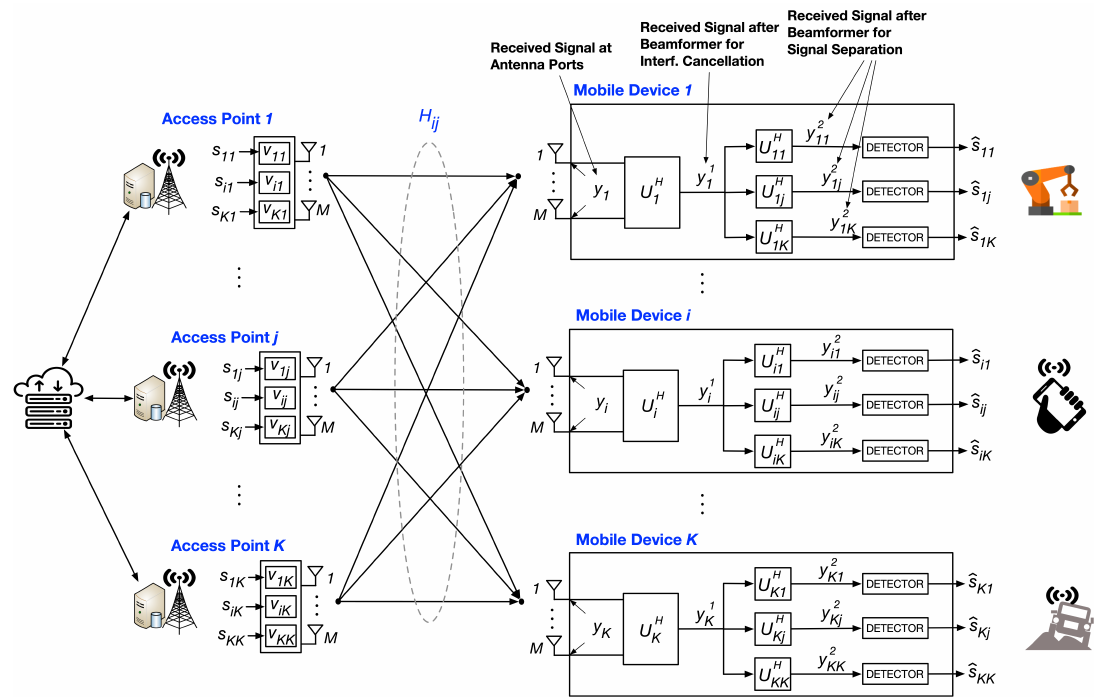
Figure 2. K -User MIMO X network showing the application of precoders at the access points as well as stage 1 and stage 2 beamformers (Equations